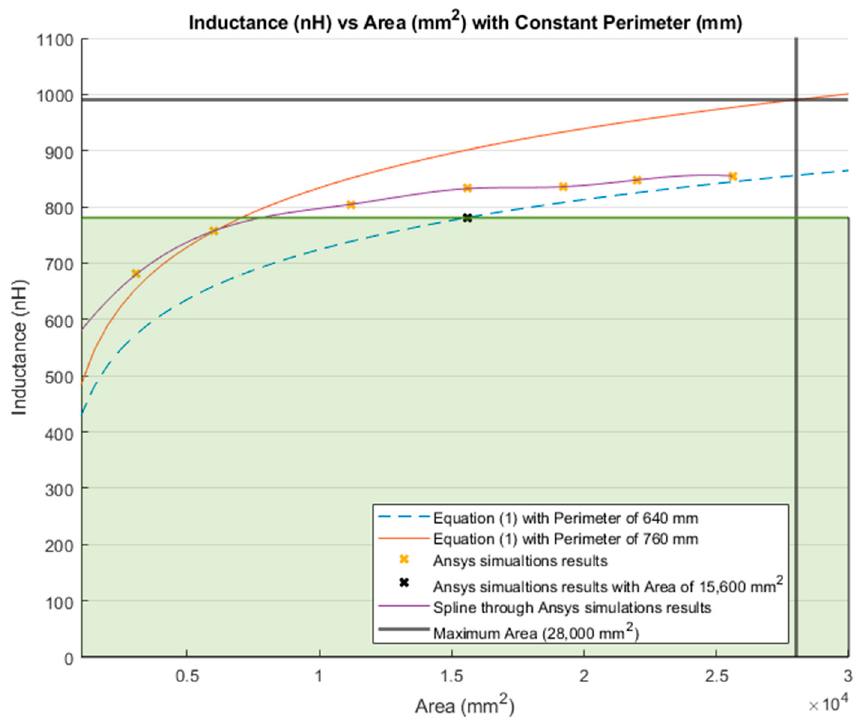
Figure 22. Inductance calculation with a constant perimeter (mm) and a variable area (mm 2 ). Highlighted in green shading is 78.81% of the total inductance change.